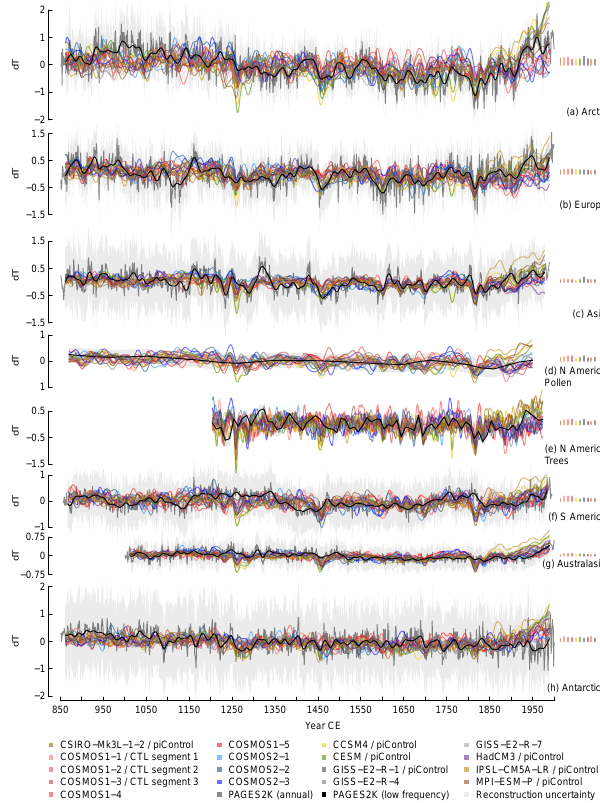
Figure 1. Series of simulated temperatures and PAGES 2k recon- structions for the seven continent-scale regions. The reconstructions are shown at their original resolution and after a smoothing using a 23-year Hamming filter, except for the North American reconstruc- tions. Only the smoothed series are shown for models. Grey shading denotes each reconstruction’s original uncertainty estimates. Seg- ments on the right indicate the unforced variability in the 23-year Hamming filtered times series in the respective control simulations (standard deviation of the time series, colours as in the caption). The anomalies are computed compared to the mean of the time series over the full length of temporal overlap between simulations and reconstruction. Note the different scales in the y axis of the various